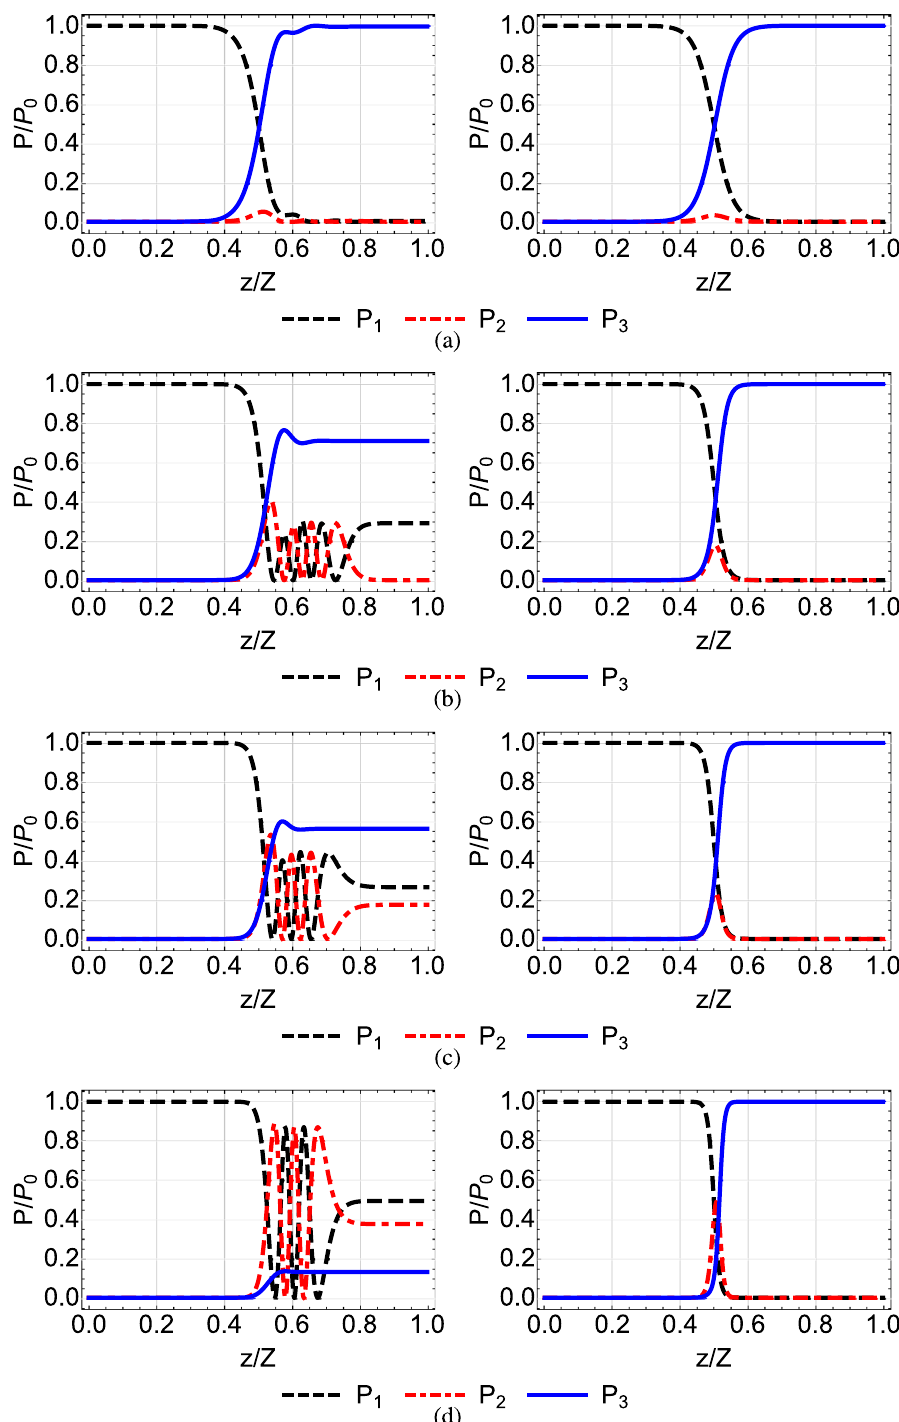
Figure 3. Normalized power P i ( z )/ P 0 at each waveguide as a function of normalized distance, for the Gaussian (left column) and modified shortcut (right column) coupling coefficients of Fig.